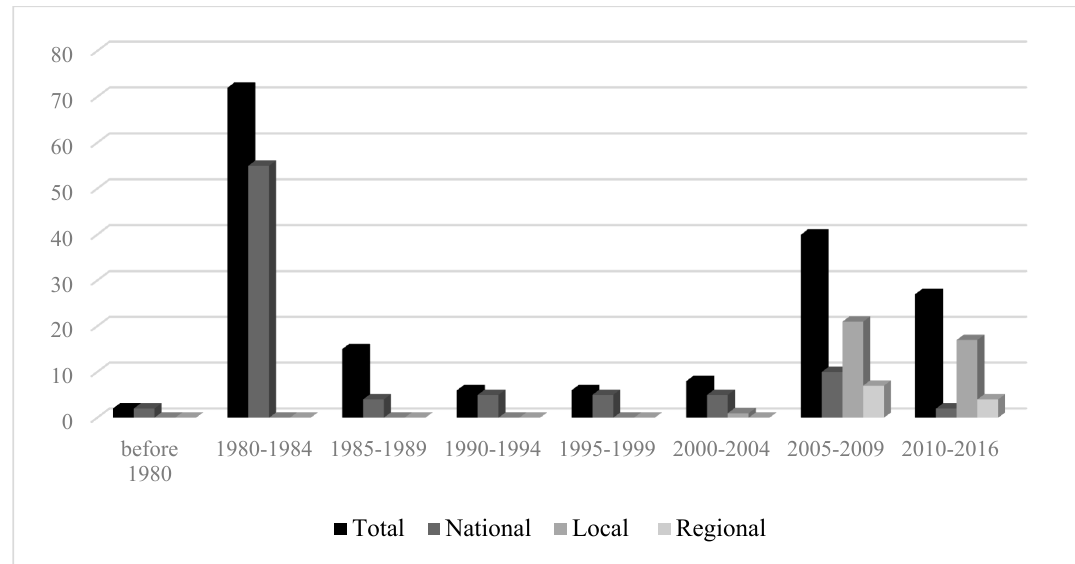
Figure 2. Over-time amount of news coverage by native and foreign newspapers.